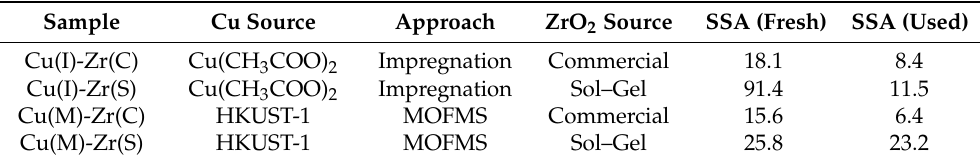
Table 1. Sample names, copper sources, approach for copper deposition, type of support, and specific surface areas (m 2 /g) of fresh and used